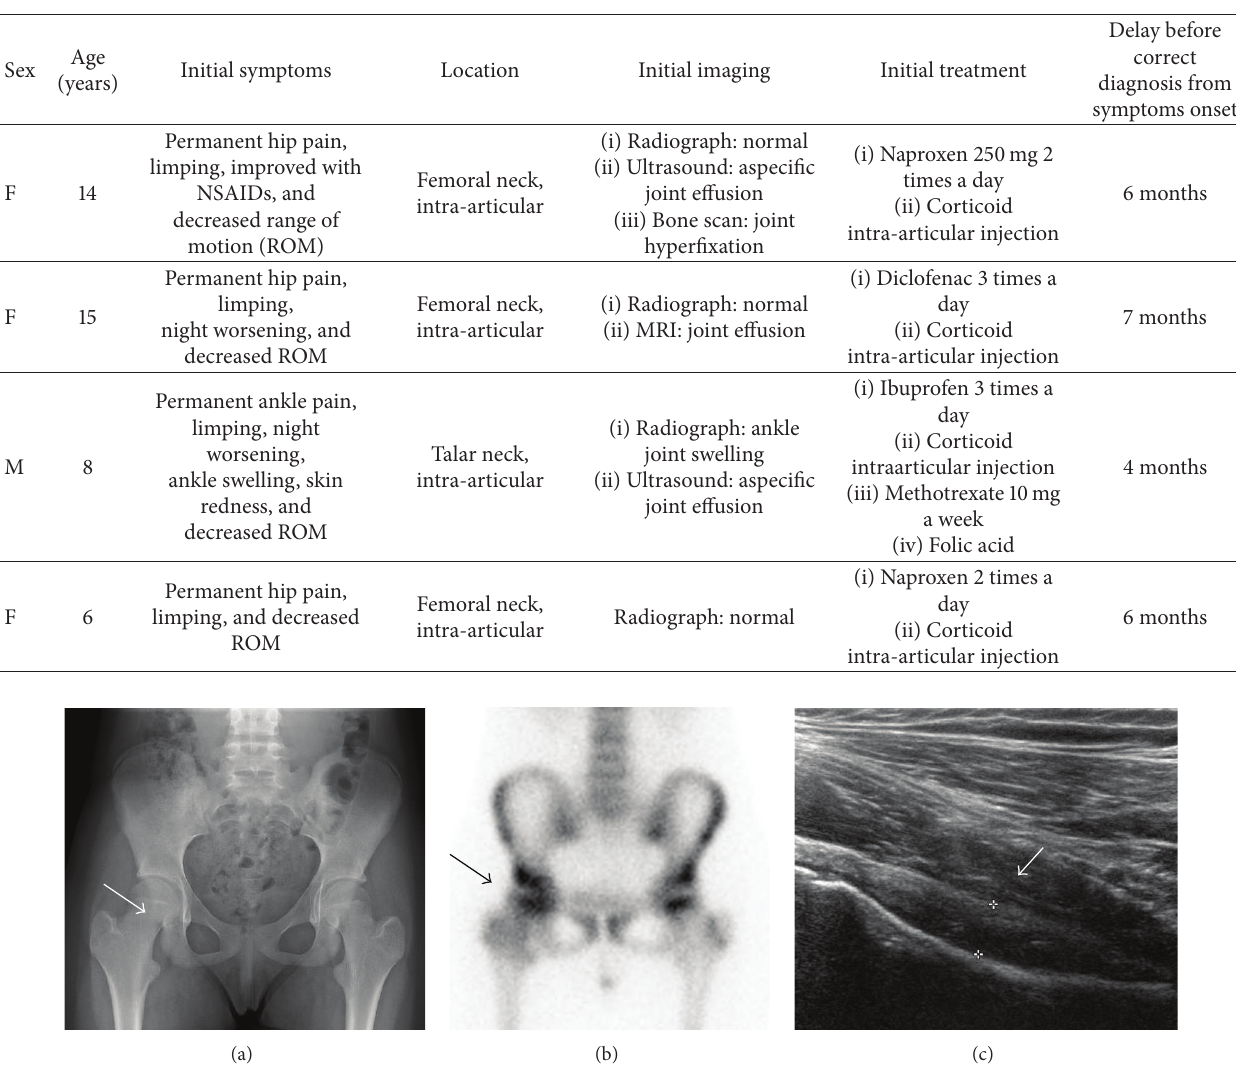
Table 1: Clinical data of the patients.